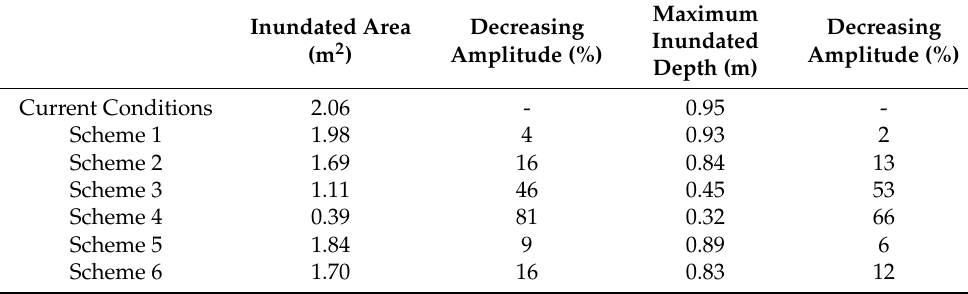
Table 2. Simulation statistics of different schemes against waterlogging under designed rainfall